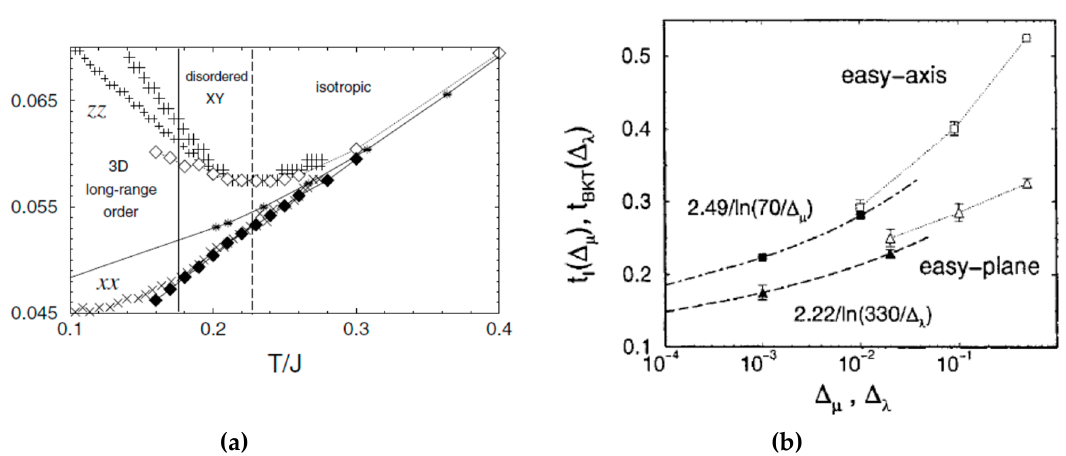
Figure 10. ( a ) Uniform susceptibility of Sr 2 CuO 2 Cl 2 (thin and thick pluses represent χ zz , crosses - χ xx ) compared to the theoretical predictions for the S = 1/2 easy-plane XXZ model on the square lattice with ∆ λ = 10 − 3 ( χ zz –open diamonds, χ xx –full diamonds). Stars represent the susceptibility of the isotropic HAF on the square lattice. (Reproduced with permission from reference [96]); ( b ) Phase diagram of the S = 1/2 XXZ model on the square lattice for weak anisotropies. The curves in the low-anisotropy region, i.e., Δ μ , λ < 10 − 1 , represent the behavior of the reduced critical temperatures t I,BKT = k B T I,BKT / J , described by the corresponding expressions. (Reproduced with permission from reference [97]).